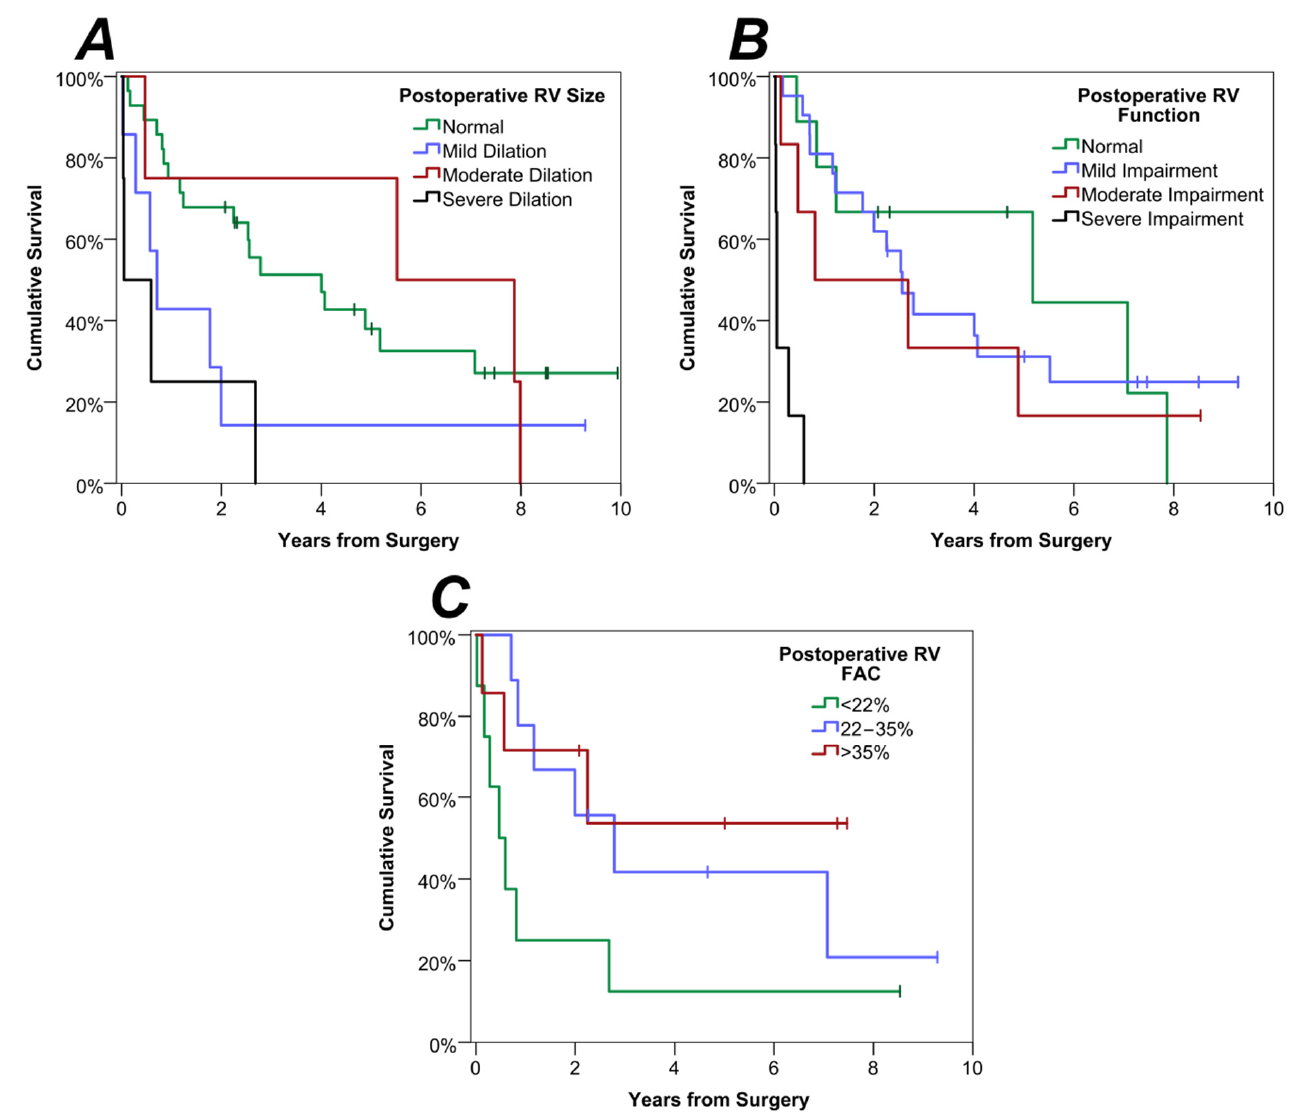
Figure 3. Kaplan-Meier Curves of Survival by Postoperative TTE Parameters. For the plot of postoperative RV FAC, patients were divided into three groups, based on tertiles of the distribution, to visualise the association with postoperative survival. Separate curves were produced for subgroups defined by postoperative ( A ) RV size and ( B ) RV function. In ( C ), patients were divided into three subgroups, based on tertiles of the distribution of postoperative RV FAC.